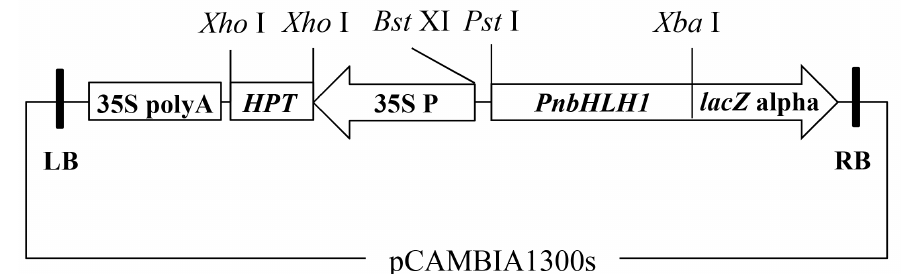
Figure 10. T-DNA region of the plant expression vector pCAMBIA1300s- PnbHLH1 . Intermediates: 35S poly A, terminator of CaMv 35S gene; HPT , hygromycin phosphotransferase gene; 35S P, 35S